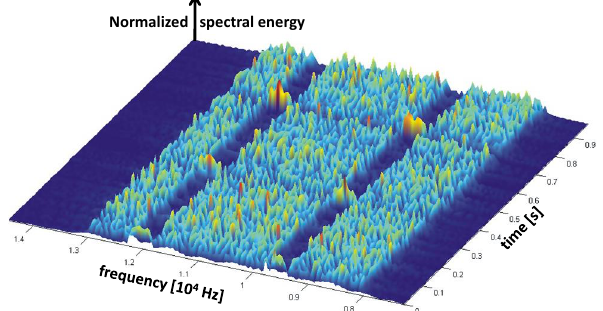
Fig. 5. Spectrogram of transmitted (electrical output) signals of a HAM.node modem in coherent DPSK (differential phase shift key- ing) OFDM (orthogonal frequency division multiplex modulation) mode for communication in near vertical